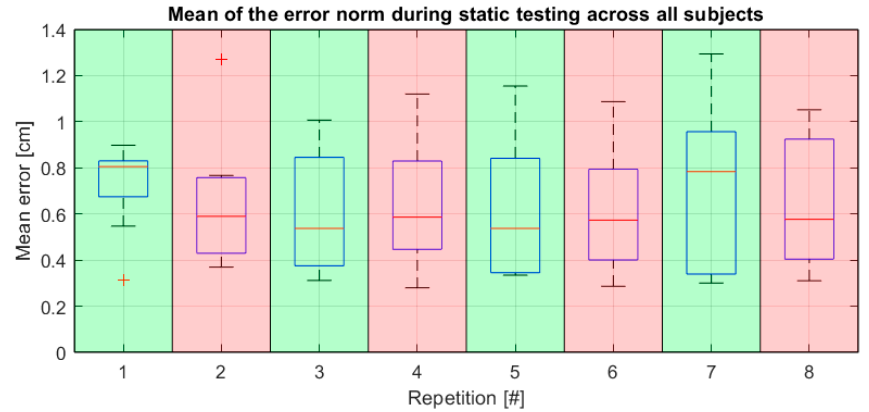
Figure 4. Boxplot over all subjects of the mean error norm measured over each static testing session.